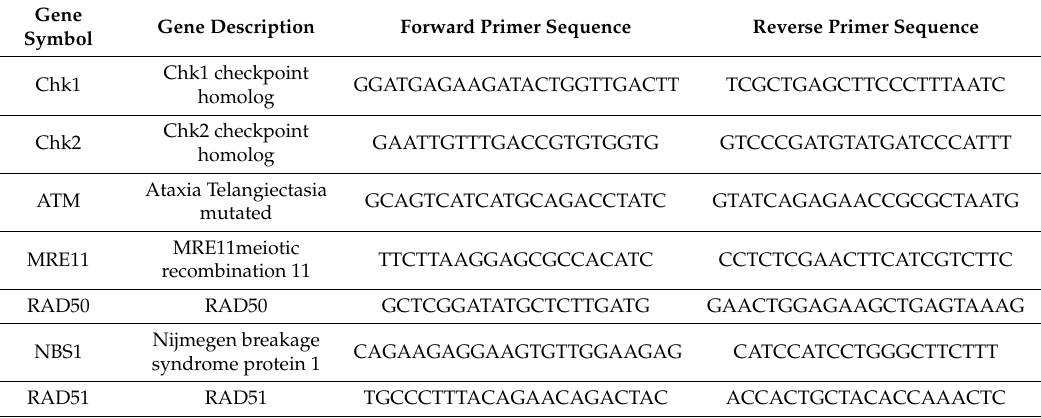
Table 2. Rat primer sequences for